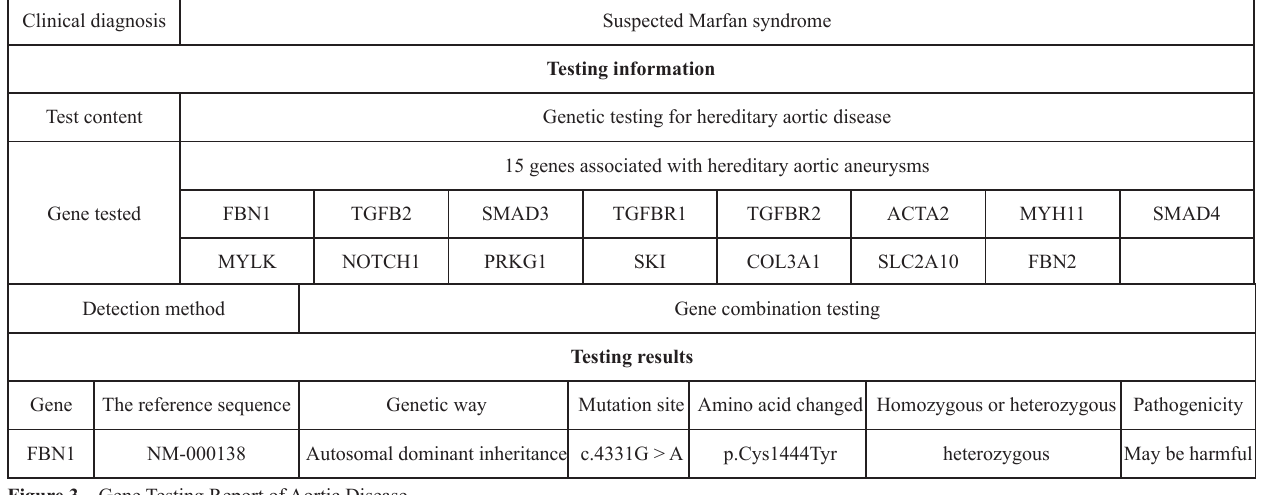
Figure 3 Gene Testing Report of Aortic Disease